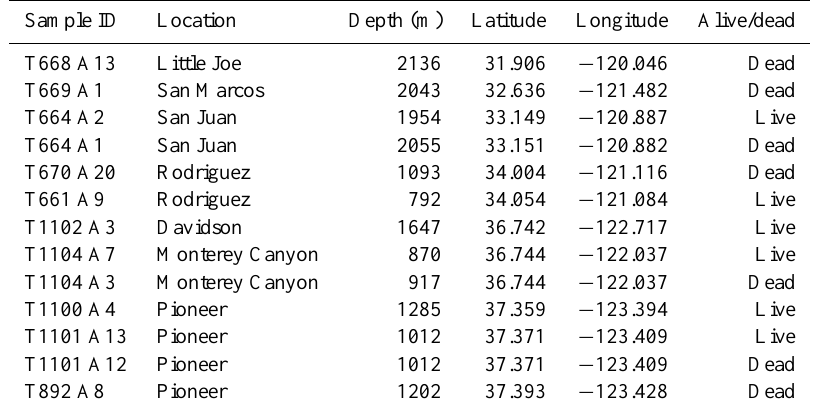
Table 1. Coral samples utilized in this investigation. All corals were collected from seamounts on the California margin, with the exception of corals collected within the Monterey Canyon area.